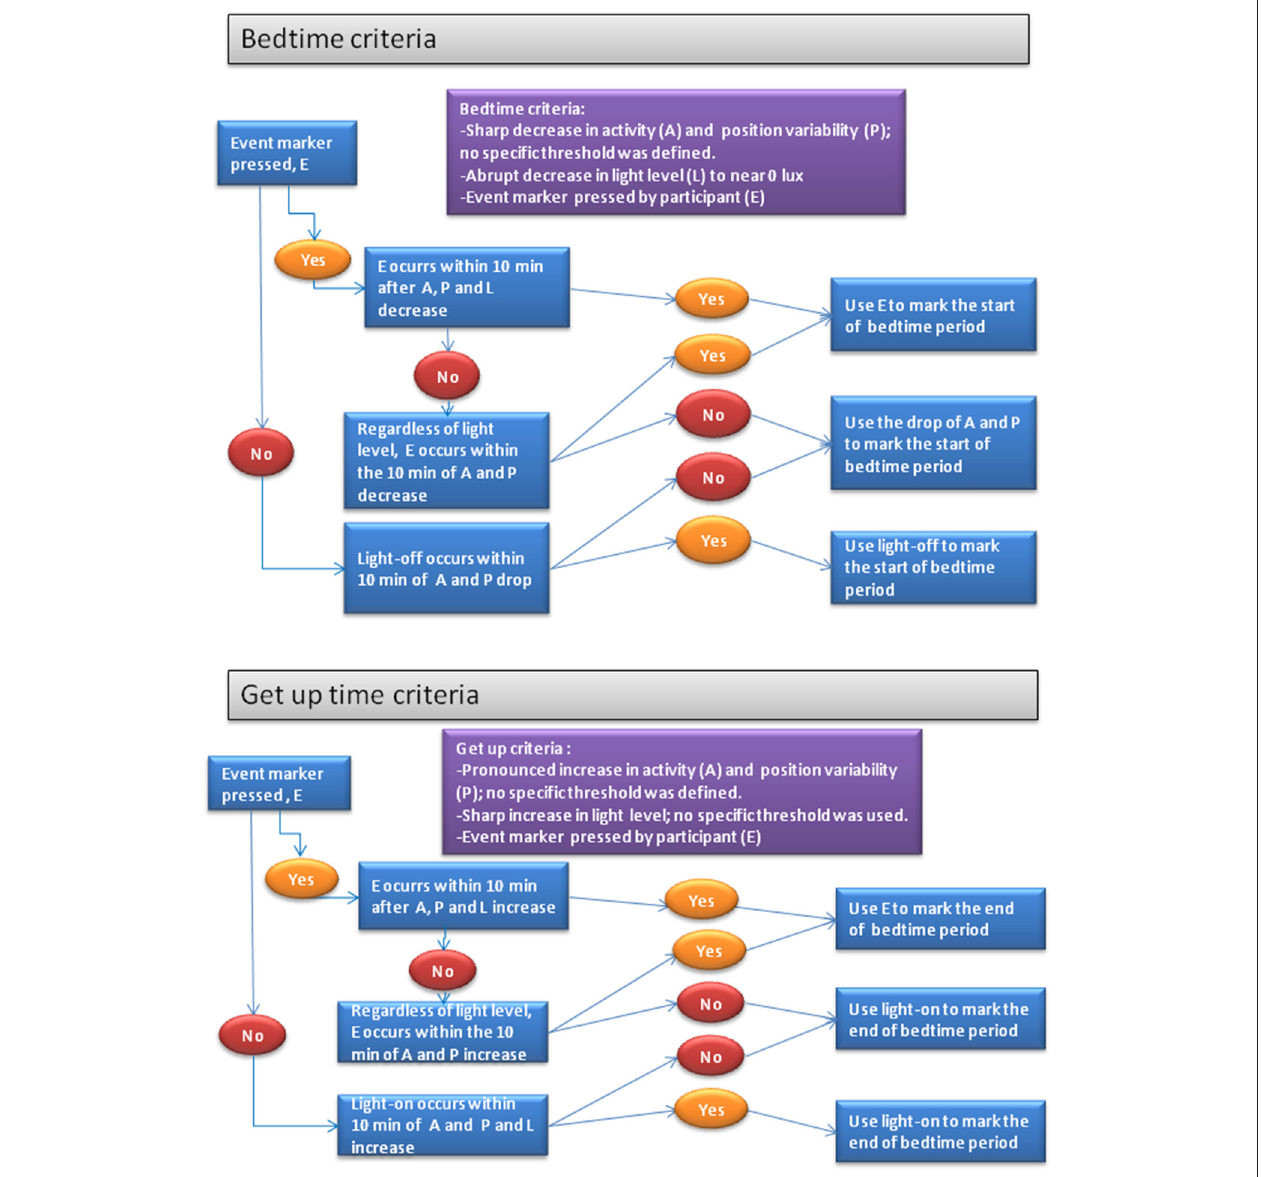
FIGURE 2 | Decision trees for the marking, using criteria objectifiable by an expert, of the sleep interval defined as the time between the voluntary start of sleep (bed time) and the end of the time spent in bed (get up time). The expert uses the criteria of: the event marker (E), lights on and off (L), motor activity (A), and stability of wrist position